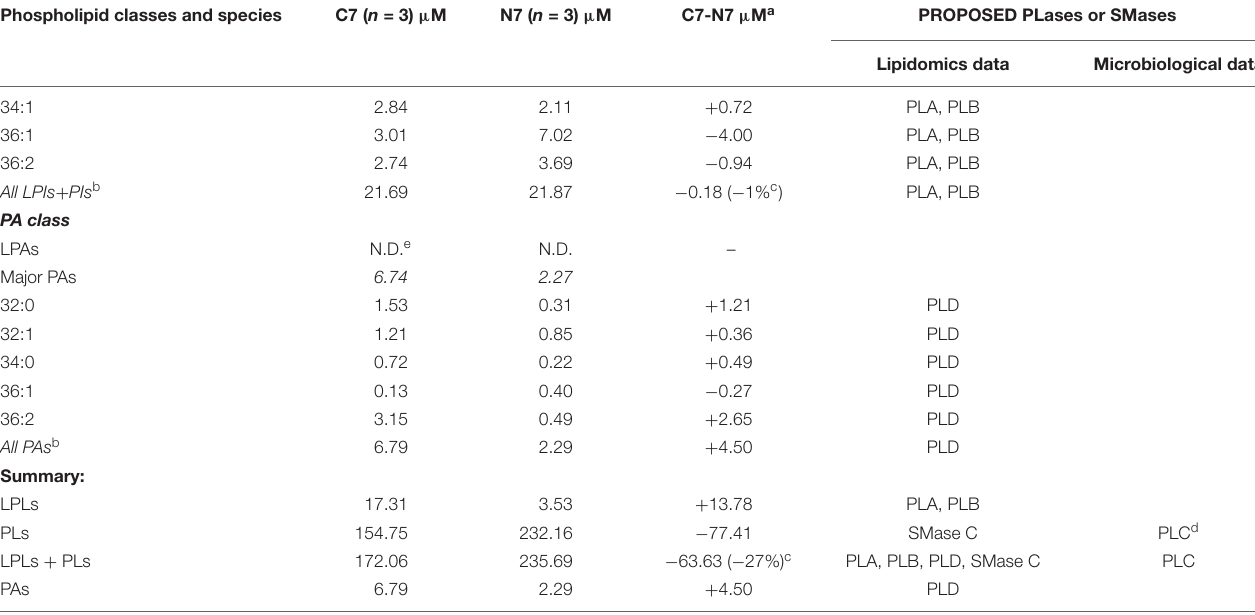
samples, most likely leading to a moderate decline in detected phospholipid levels for raw milk samples incubated for 3–7 days ( Figure 2 ). For the three raw milk samples, the average recorded initial phospholipid concentration was 300 µ M ( Figure 2 ), equivalent to approximately 23 mg/100 ml of raw milk, which is in line with the study by Garcia et al. (2012) that reported 20.4 mg phospholipids/100 ml of cow